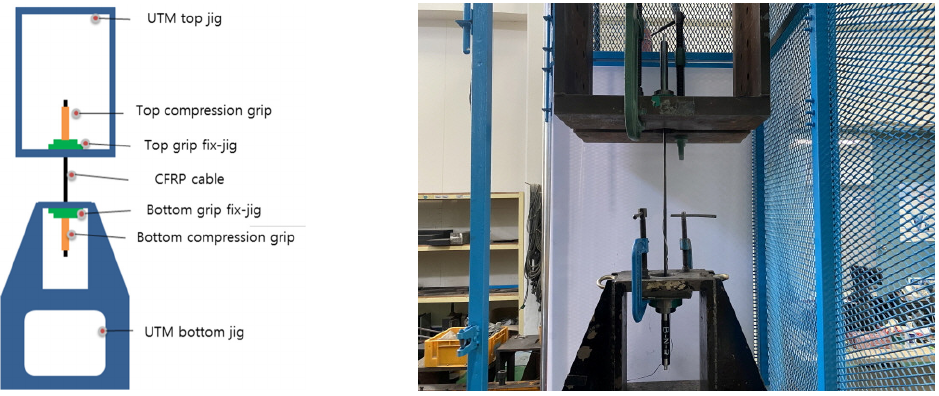
Figure 3. Tensile test setup for round steel pipe mold specimens [36].